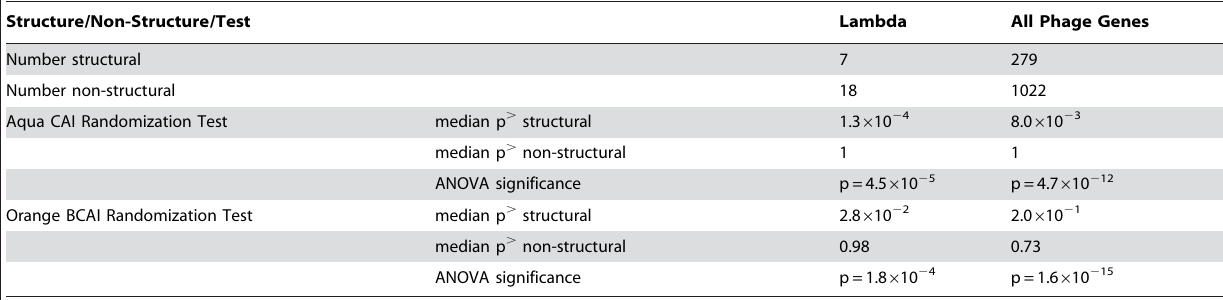
Structure/Non-Structure/Test